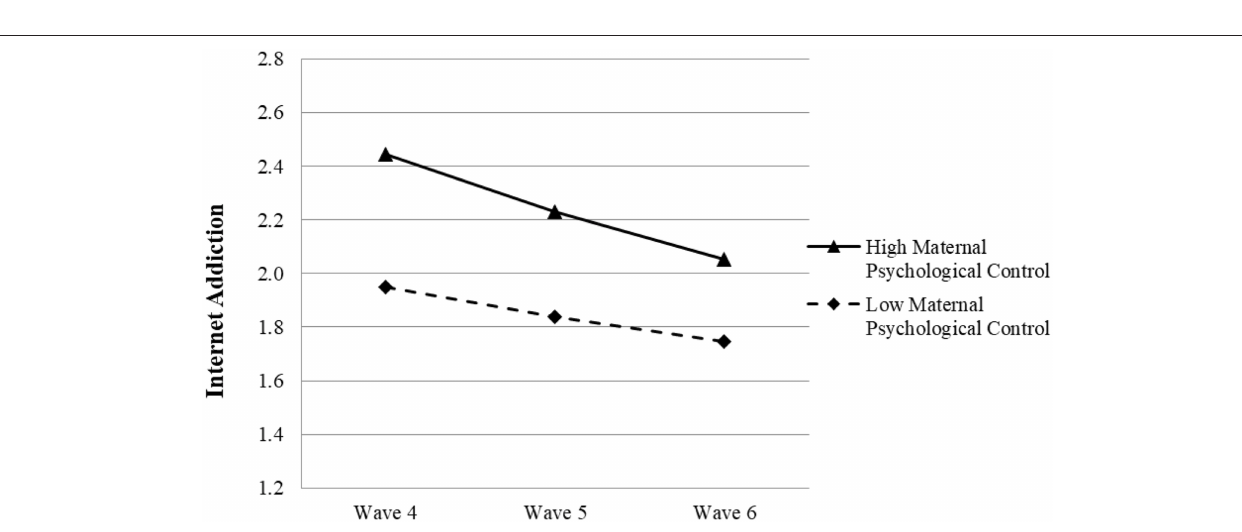
Cohen’s f 2 = 0.001). However, maternal psychological control predicted children’s IA at the two waves (Wave 5: β = 0.10, p < 0.001, Cohen’s f 2 = 0.009; Wave 6: β = 0.10, p < 0.001,